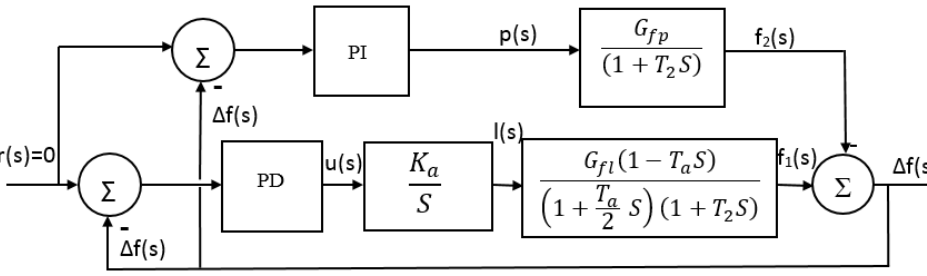
Figure 4. Model validation plotting curve of